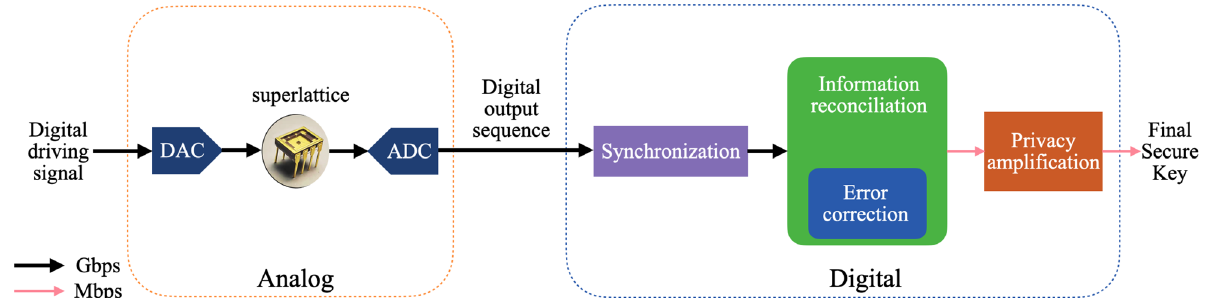
Figure 1. The procedure for generating final secure key using SSL-SKD.